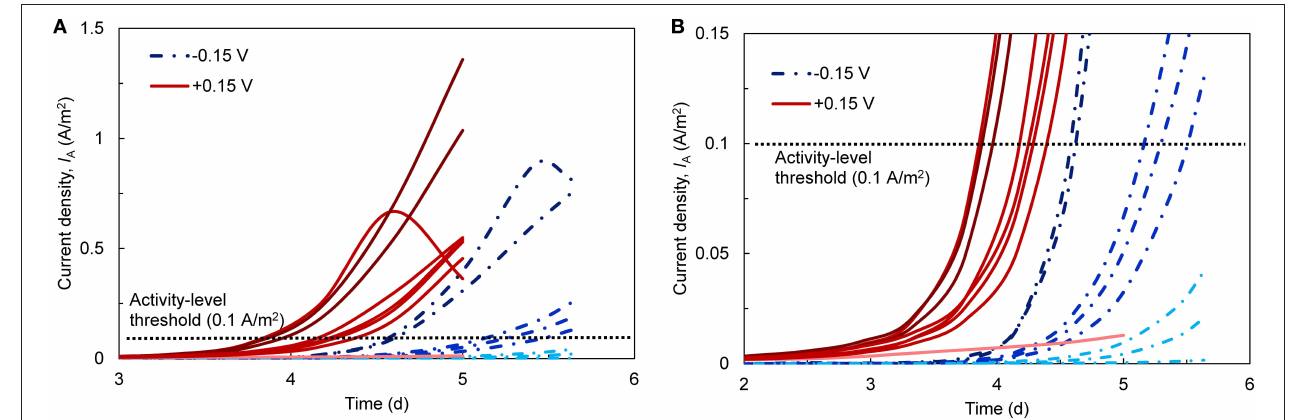
FIGURE 1 | (A) Current densities ( I A ; normalized to anode surface area) over time during the startup phase of the bioanodes. Eight replicates (red lines) were started with an applied anode potential [ E AN ; reported vs. the standard hydrogen electrode (SHE)] of + 0.15V and another eight (blue, segmented lines) were started at − 0.15V. The dark, medium, and light shading of the lines corresponds to high-, low-activity, and inactive bioanodes, respectively. The horizontal dotted line denotes the current density threshold (0.1 A/m 2 ) selected to define the bioanode activity level. (B) A closer view of the bioanode startup current densities with respect to the activity